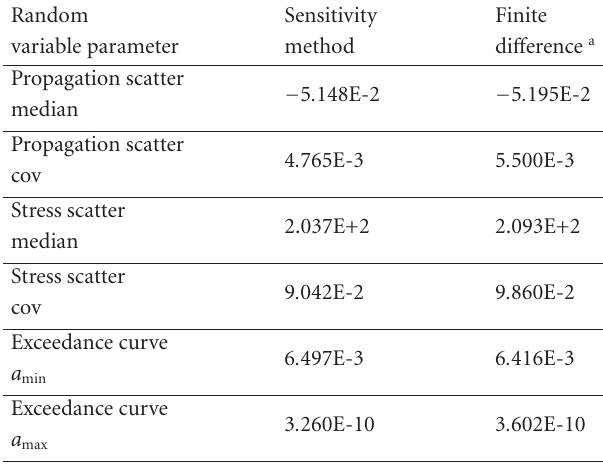
Table 2: Comparison of conditional POF sensitivity equations and finite di ff erence